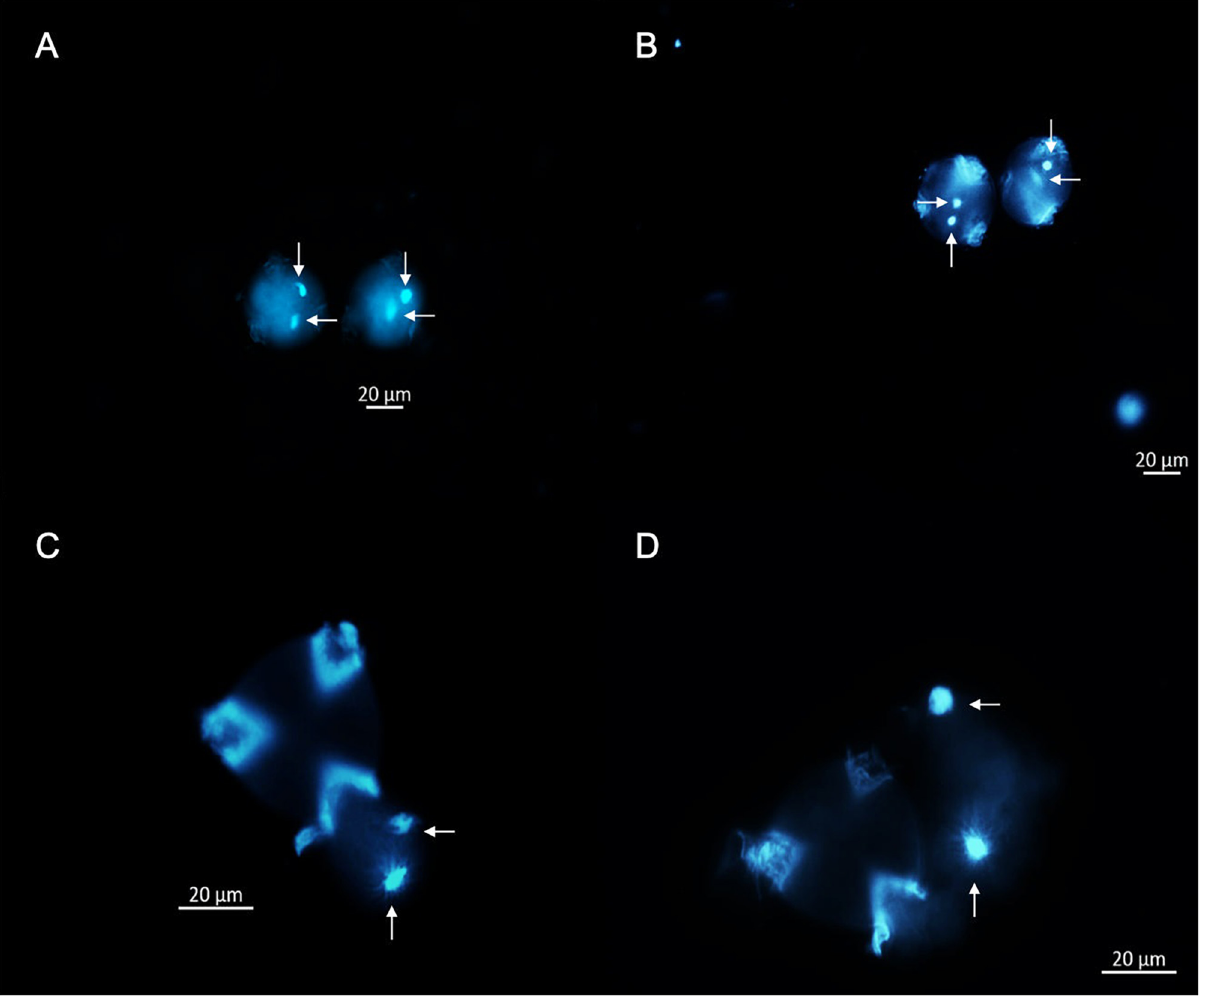
FIGURE 4 | Germination stages of P. volubilis pollen grains using GM, stained using DAPI fluorochrome, and visualized under fluorescent microscopy. (A) (Stage 1), pollen grains not completely germinated, lacking pollen tube and stained directly. (B) (Stage 2), pollen grains showing very conspicuous germination apertures. (C) (Stage 3) pollen partially germinated with an observable migration of vegetative and germinative cells. (D) (Stage 4), pollen grains germinated and conspicuous pollen tubes with male germination unit (MGU) migrating across the tube. Germinative cells are illustrated in vertical arrows, and vegetative nuclei are pointed by the horizontal arrows. A and B were observed at 20X and C and D at